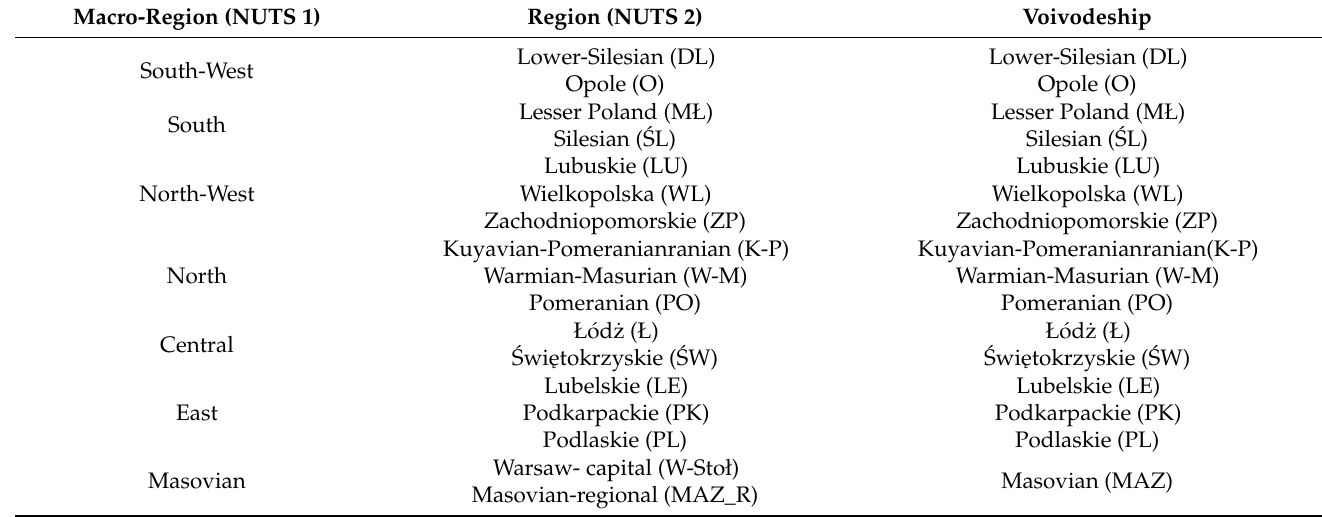
Table 2. Relations between macro-regions, regions and voivodeships in